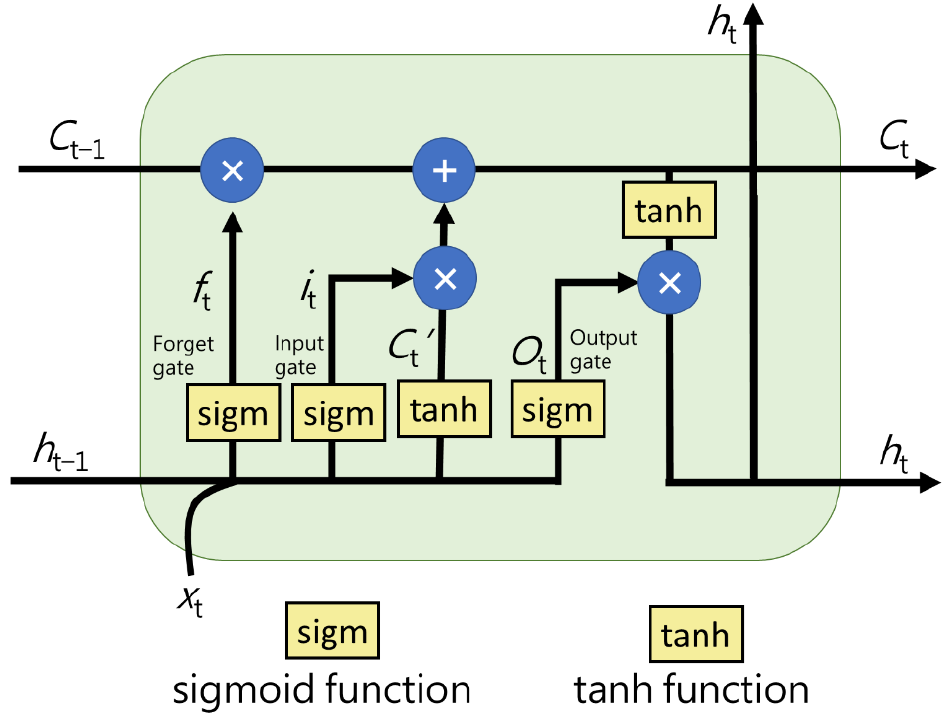
Figure 3. Long short-term memory (LSTM) architecture.